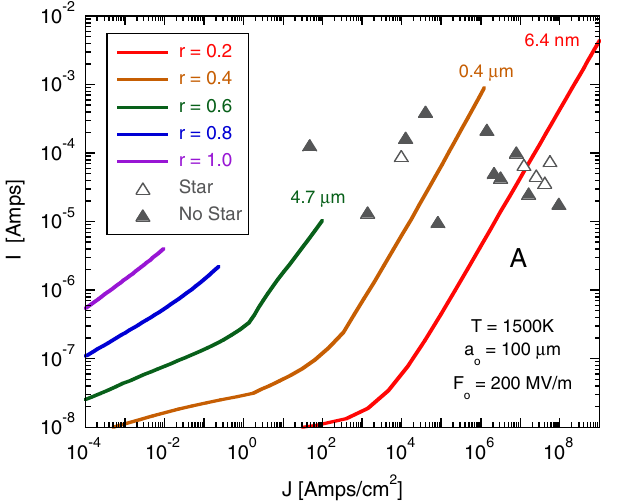
FIG. 12. (Color) Same as Fig. 11, but for fixed n (cid:2) 6 and different temperatures. Increasing T along such lines models